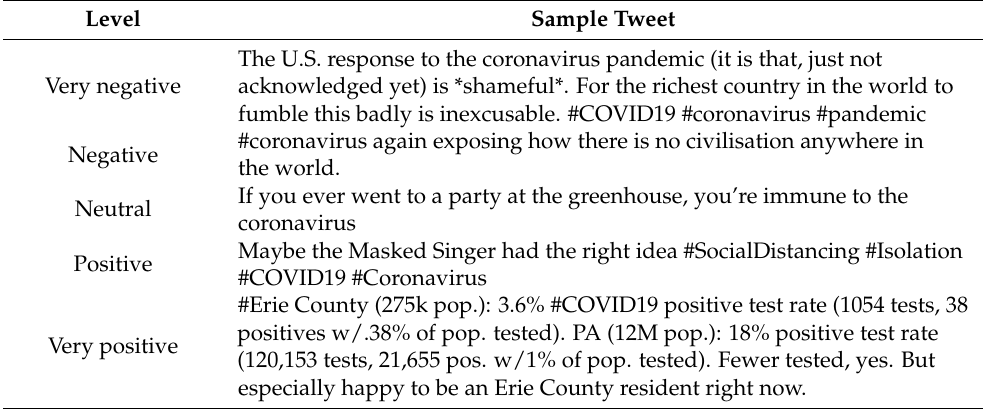
Table 1. Sample tweets representing different sentiment levels based on manual annotation.